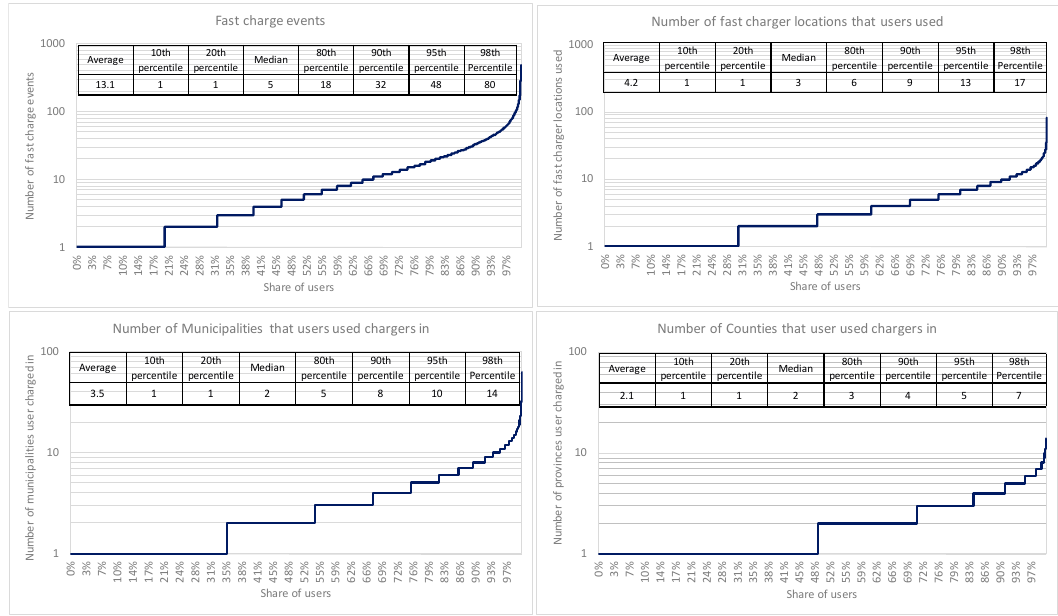
Figure 17. Number of fast charge events, fast chargers used in total, number of Counties and municipalities fast chargers where used in during 2017 by users fast charging both in 2016 and 2017. Log scale. Average, median value, and 10 th , 20 th , 80 th , 90 th , 95 th , 98 th percentiles in subfigures. Source: Dataset 1 and own analysis.